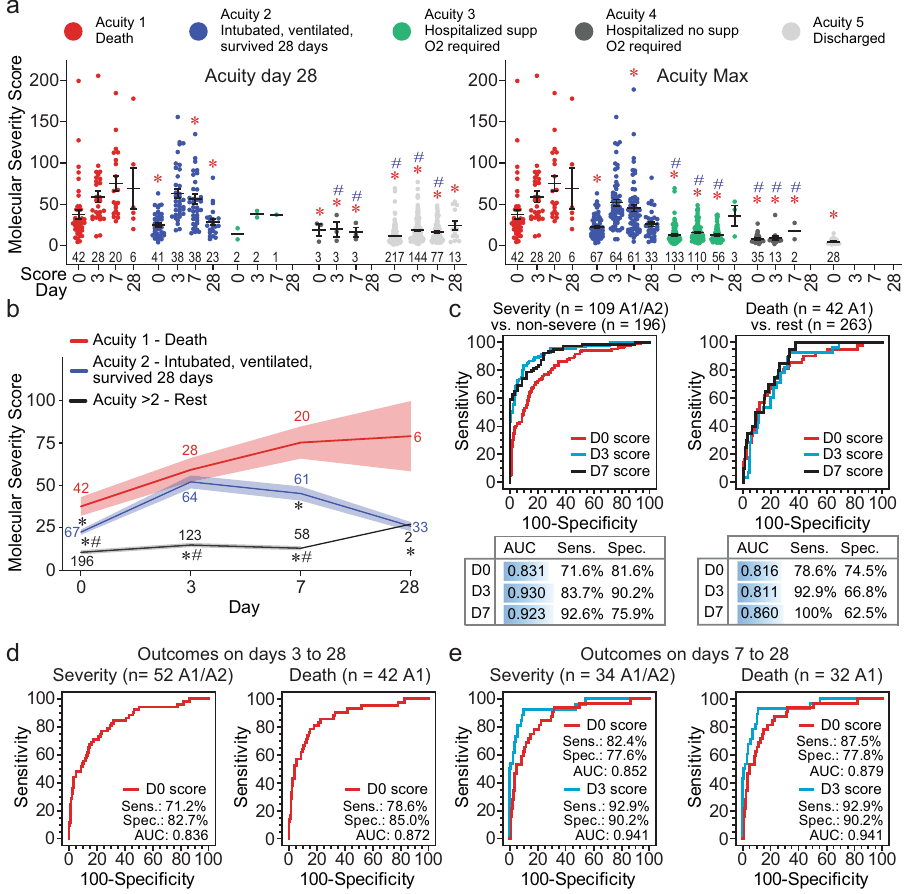
Fig. 6 Validation of the COVID-19 molecular severity score in the Massachusetts General Hospital (MGH) cohort. a The molecular severity scores were calculated based on the expression of the 12 proteins measured using the Olink platform in the MGH cohort (Supplementary Data 5). The calculated scores (±SEM) are shown in the scatter plots over time according to the WHO ordinal scale for COVID-19 severity, acuity groups 1 – 5 3 , on day 28 after recruitment (left panel) or the maximum acuity over the 28-day study period (right panel). The number of patients in each group is shown in the bar graph. b Time curve of the molecular severity scores (mean ± SEM, number of patients stated for each time point in each group) for the severe COVID-19 groups, A1 group (death) and A2 group (intubated, ventilated but survived 28 days), compared to the remaining groups (A3 – A5). * and # in a , b denote statistical differences ( p < 0.01, refer to Supplementary Data 6 for exact p -values) between the A1 group to the other and the A2 group to the other groups, respectively (two-way ANOVA with Tukey ’ s multiple testing correction). c Summary of ROC curve analyses to evaluate the performance of the molecular severity scores on days 0, 3, and 7 in the MGH cohort to predict the maximum COVID-19 severity throughout the 28-day-study. d , e Summary of ROC curve analyses to evaluate the performance of the molecular severity scores on day 0 or day 3 to predict COVID-19 severity or death between days 3 to 28 or days 7 to 28, respectively. The AUC, sensitivity (sens.), speci fi city (spec.), and the number of severe events in each ROC curve are stated. All ROC curves were statistically signi fi cant ( p < 0.0001 from AUC of 0.5, DeLong et al. method 70